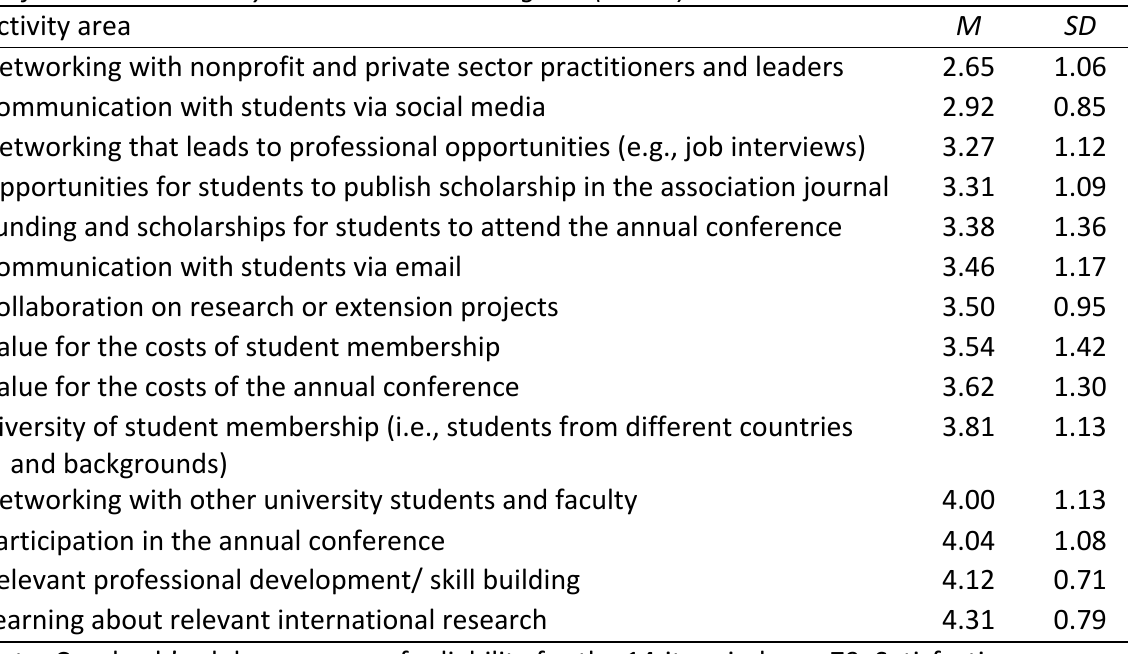
Table 3 Satisfaction with Activity Areas – Lowest to Highest (n = 26) Activity